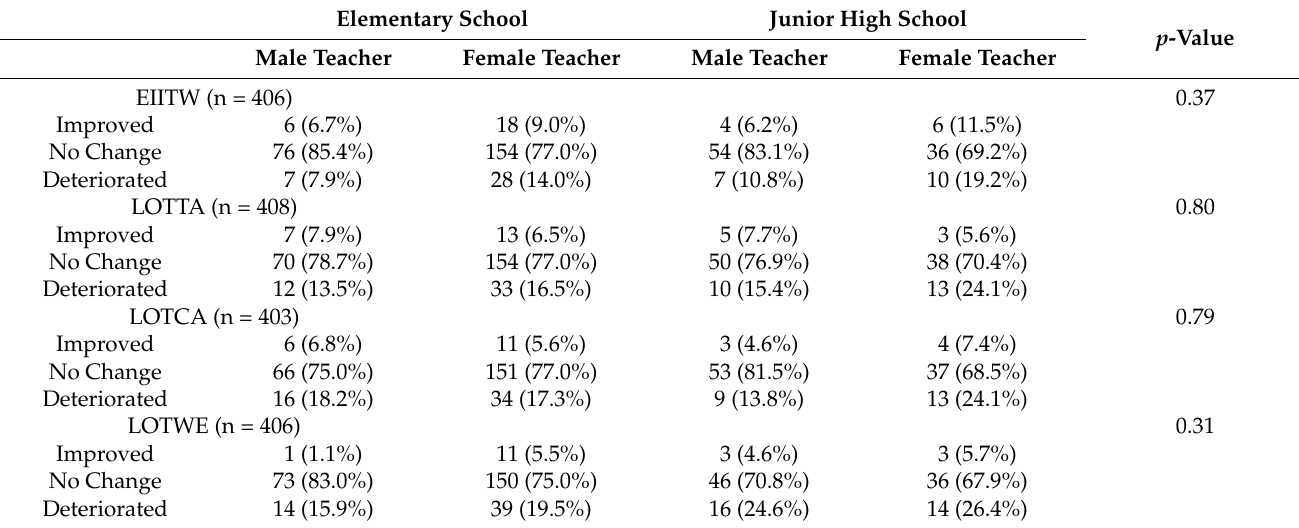
Table 4. Impact of COVID-19 on work before and after school closures.